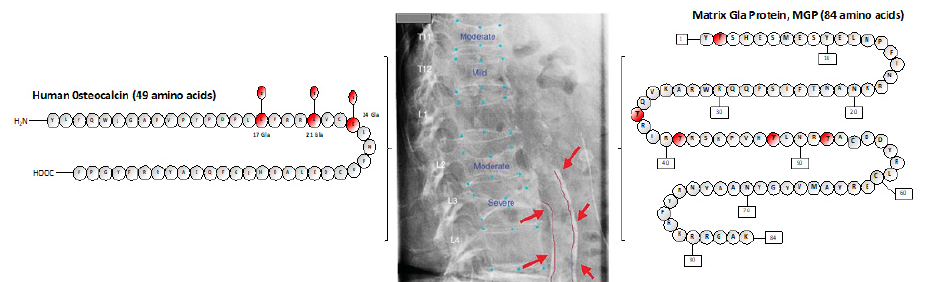
Figure 1. The two better-studied vitamin-K-dependent proteins, bone Gla protein (BGP, osteocalcin) and matrix Gla protein (MGP), contribute to cardiovascular and bone health in the general population and kidney transplant patients, who have an increased risk of cardiovascular events and bone fractures. Aortic calcifications and vertebral fractures are typical complications seen in CKD patients. Reprinted from Fusaro M, Gallieni M, Jamal SA. Fractures in chronic kidney disease—neglected, common, and associated with sickness and death. Kidney Int. 2014;85(1):20–22.